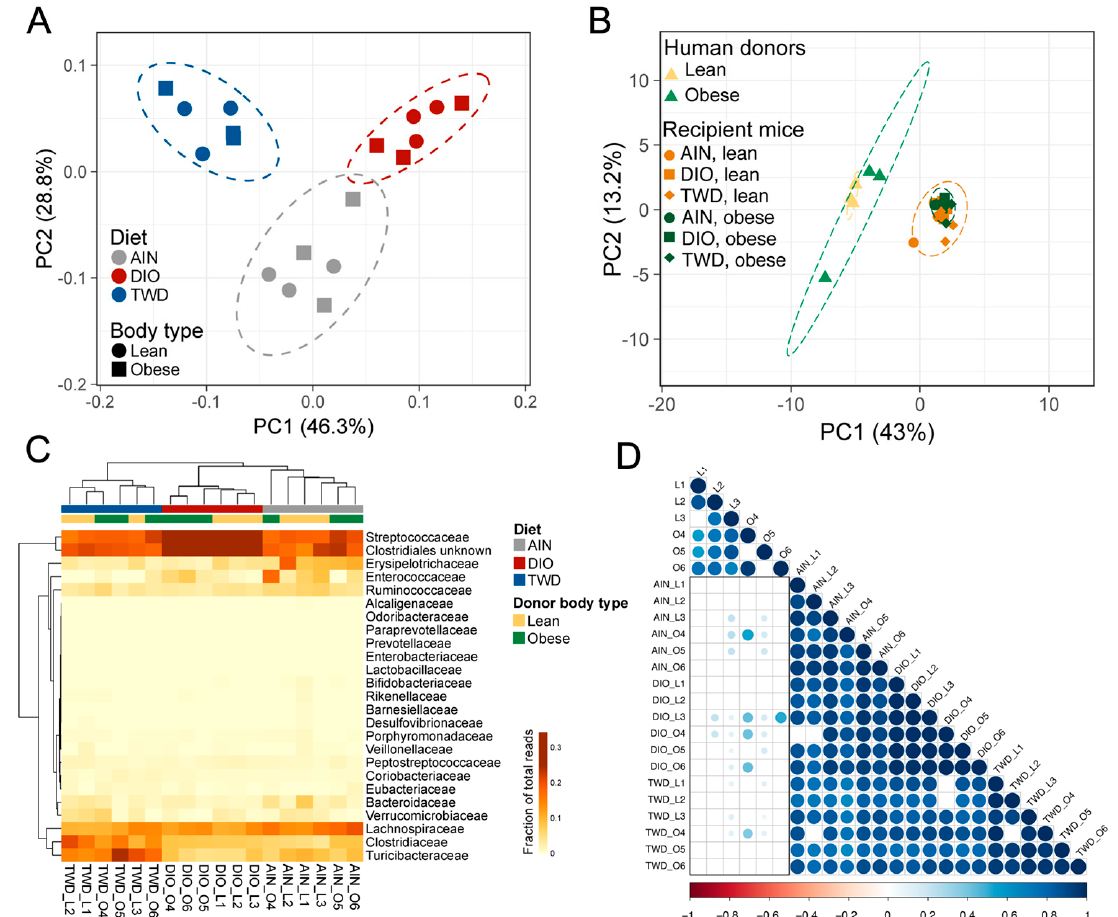
Figure 10. Hierarchical clustering and principal components analysis of recipient mouse microbiomes at necropsy. ( A – B ) PCA of family-level taxonomy data plotted according to the first two principal components for FMT recipient mice ( A ), comparing recipient mice to original human donors ( B ). Variation attributed to each component is shown. Dashed lines represent the 95% confidence ellipse. ( C ) Unsupervised, bidirectional hierarchical cluster analysis of taxonomy relative abundance data for bacteria families comprising at least 1% of the fecal microbiome from all mice prior to antibiotic treatment (pre-AB) and from each of the six human donors (lean: L1, L2, L3; obese: O4, O5, O6). Clustering was performed using Euclidian distance with average linkage. Heatmap color scale indicates relative abundance as fraction of total reads. ( D ) Pearson correlation plot showing correlation between human donor microbiomes and recipient mice. The color scale indicates the size and direction of the correlation coefficient. Only significant ( p < 0.05) correlations are shown. The black box highlights the correlation of FMT recipient mice with their human donors.